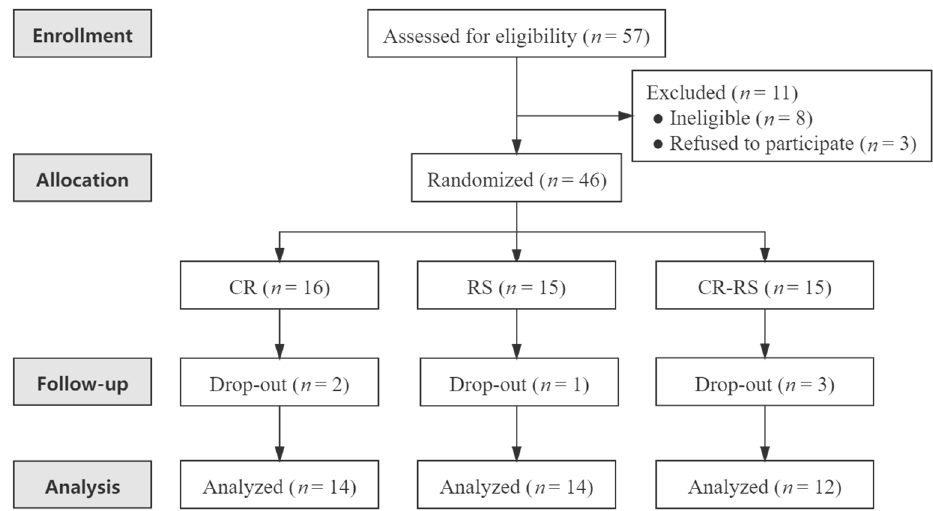
Figure 1. CONSORT flow diagram. CR, calorie restriction; RS, rope-skipping; CR–RS, calorie restriction with rope-skipping.